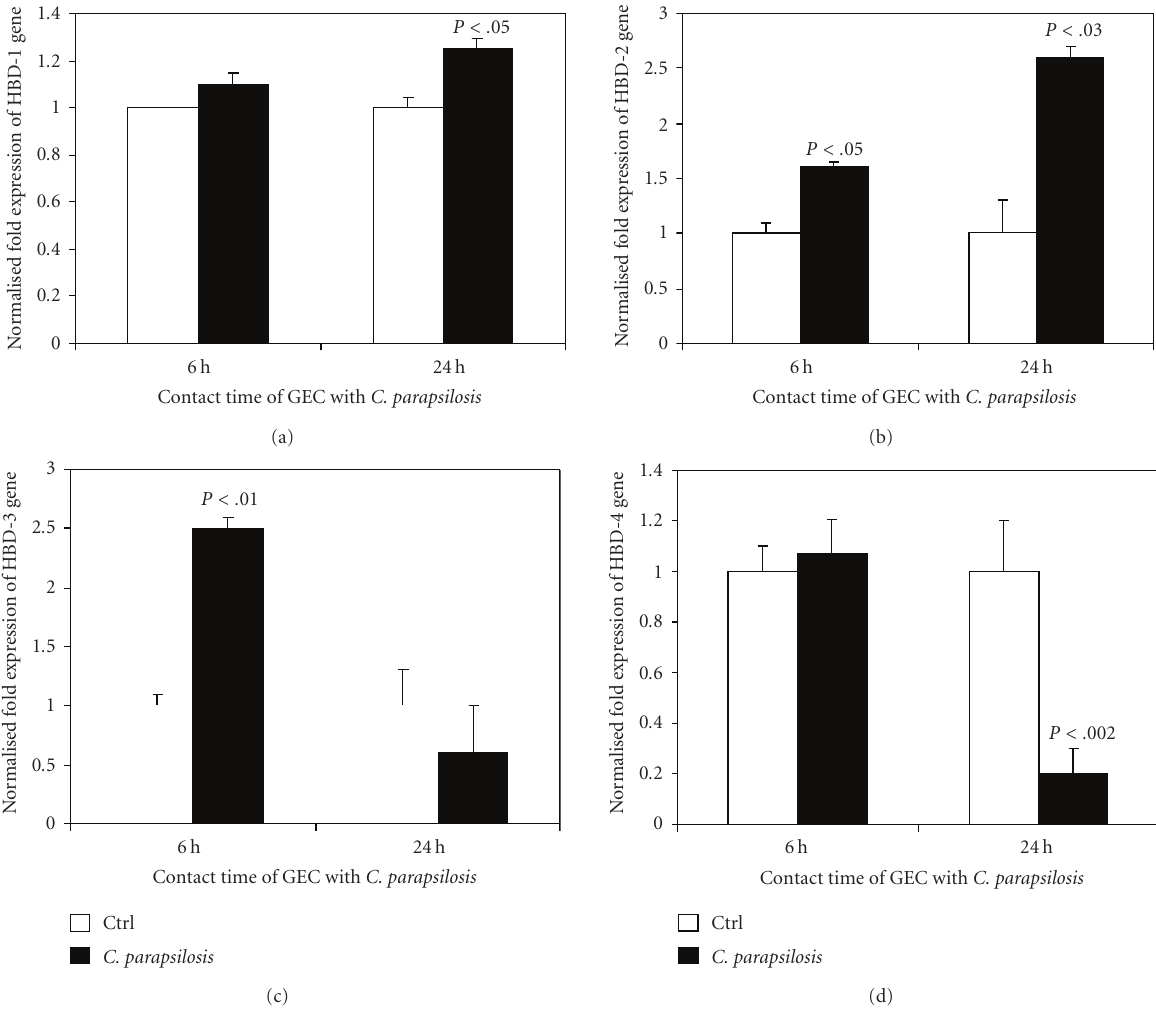
Figure 6: Quantification of mRNA expression levels of HBD-1, -2, -3, and -4 by gingival epithelial cells following infection with C. parapsilosis . Gingival epithelial cells were cultured with or without C. parapsilosis for 6 and 24 hours. Total RNA was extracted from the cells following each culture period and was used for quantitative RT-PCR of the HBD-1, -2, -3, and -4 genes, as described in Section 2. Results are presented as a fold expression of the gene in the test sample compared to this gene expression in the control. Data are expressed as means ± SD from triplicate assays of three di ff erent experiments. (a) HBD-1 expression, (b) HBD-2 expression, (c) HBD-3 expression, and (d) HBD-4 expression. GEC: gingival epithelial